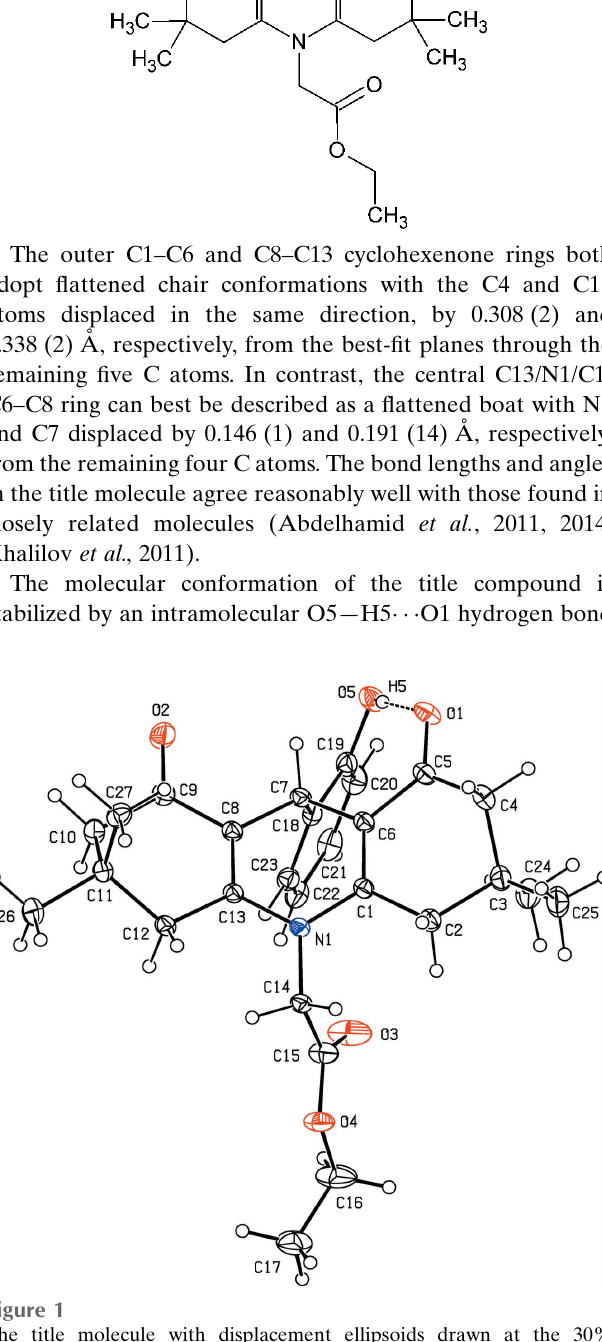
Figure 2 The molecular packing, viewed down the a- axis direction, showing hydrogen bonds as dashed lines.